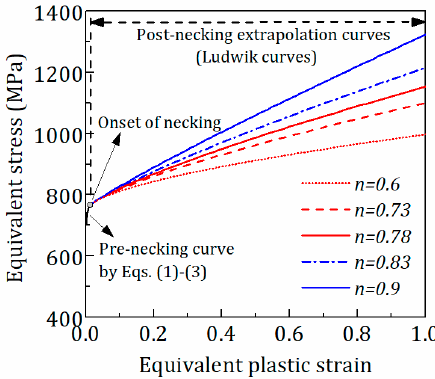
Figure 3. Ludwik curves with different n values at 500 °C.